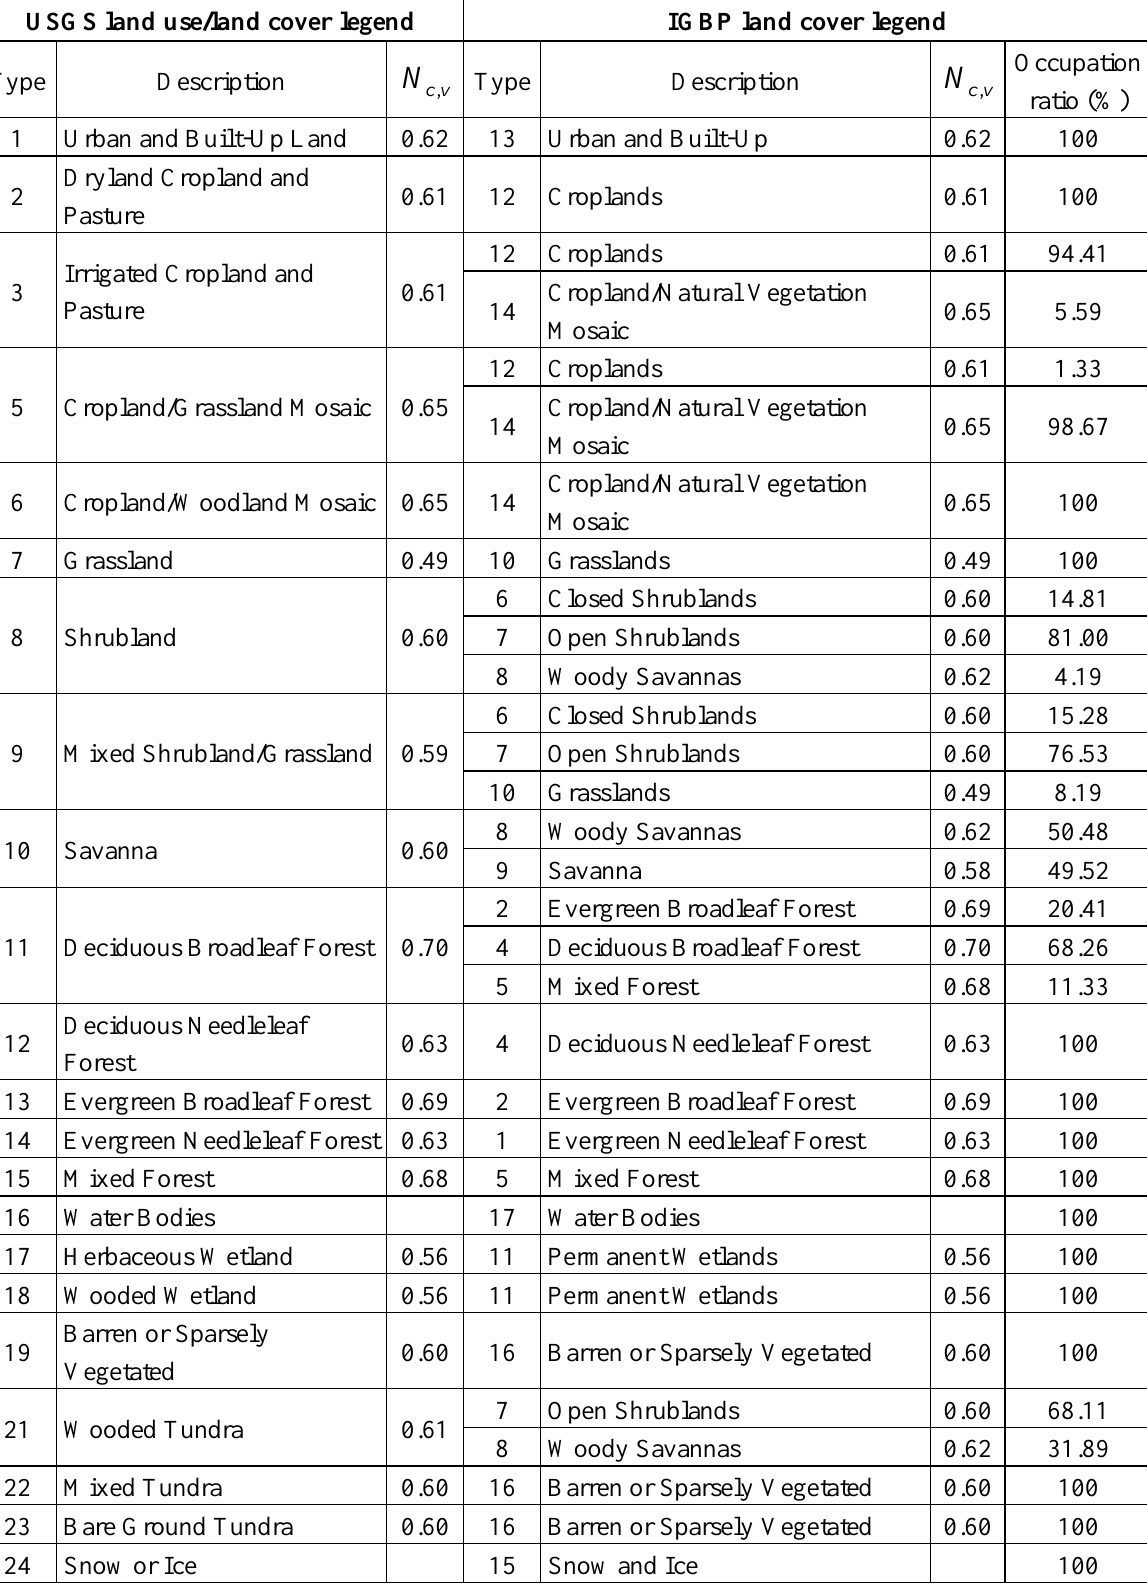
Table 1. Comparison of N between USGS and IGBP Land Cover Legends. c,v USGS land use/land cover